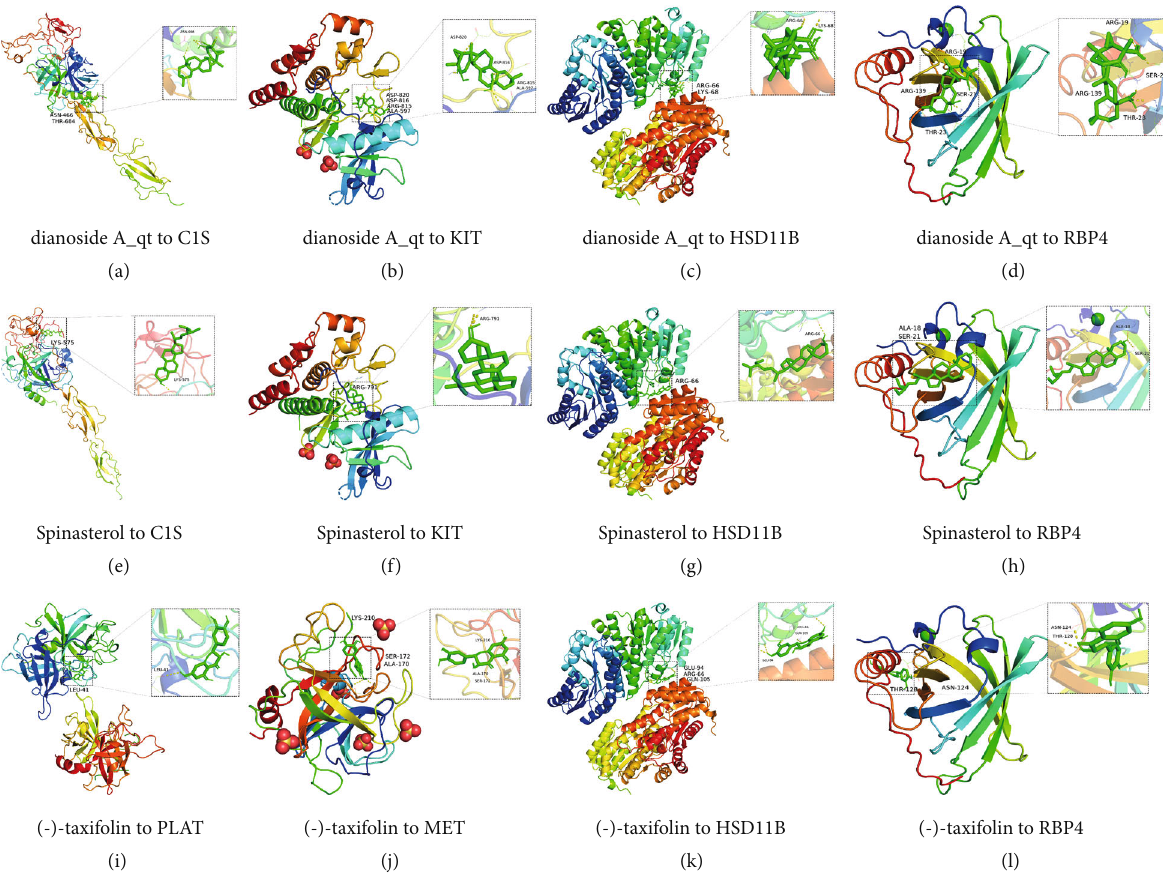
Figure 12: The docking mode and interactions between compounds and target